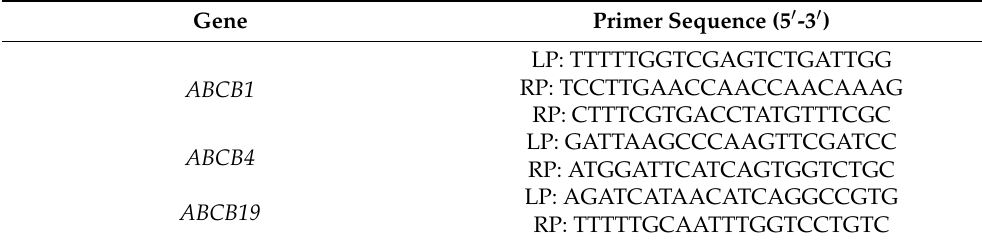
Table 3. Screening Arabidopsis T-DNA insertional mutants using specific primers.